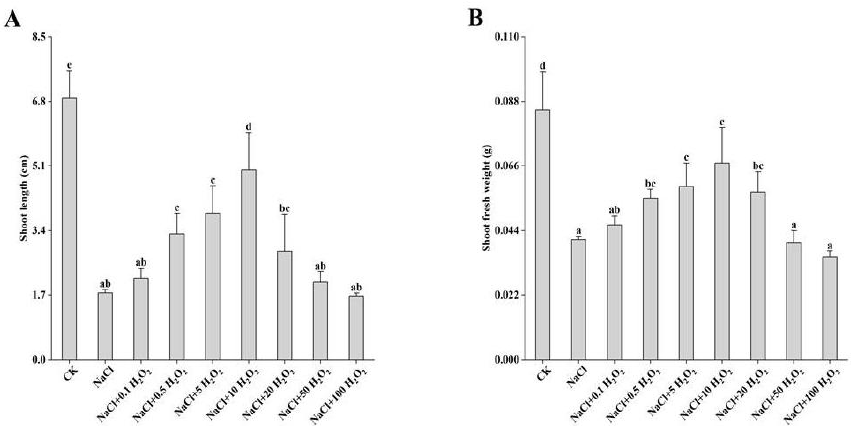
Figure 2. Effect of H 2 O 2 on SL ( A ) and SFW ( B ) of F. tataricum seedlings under NaCl stress. CK, control treatment (only water); NaCl, 50 mmol L −1 NaCl treatment; NaCl + xxx H 2 O 2 , treatments of standard NaCl + respective H 2 O 2 concentration; SL, shoot length (cm); SFW, shoot fresh weight (g). Different lowercase letters on each column indicate significant differences between treatments at p < 0.05.